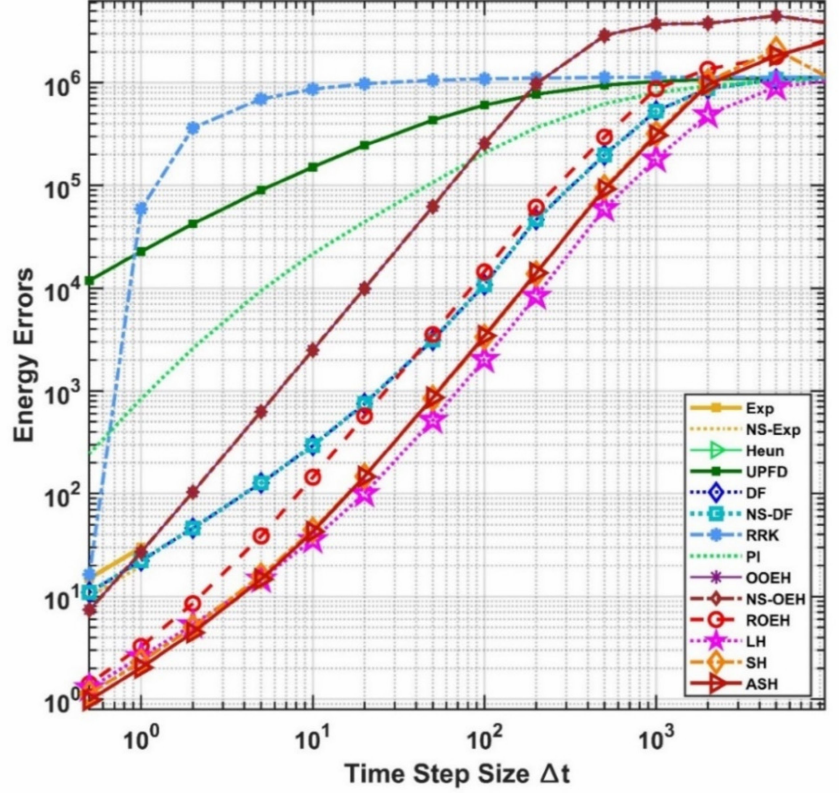
Figure 15. The energy errors as a function of the time step size for the non-equidistant